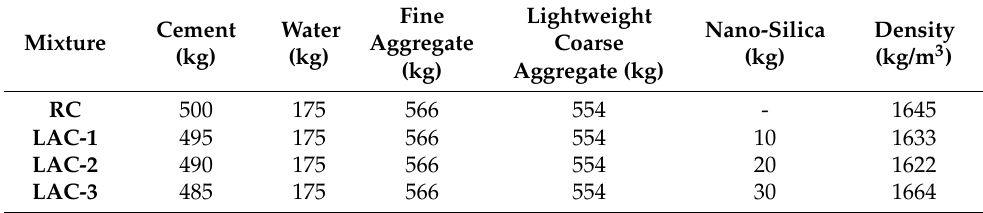
Table 1. Mix proportions for 1 m 3